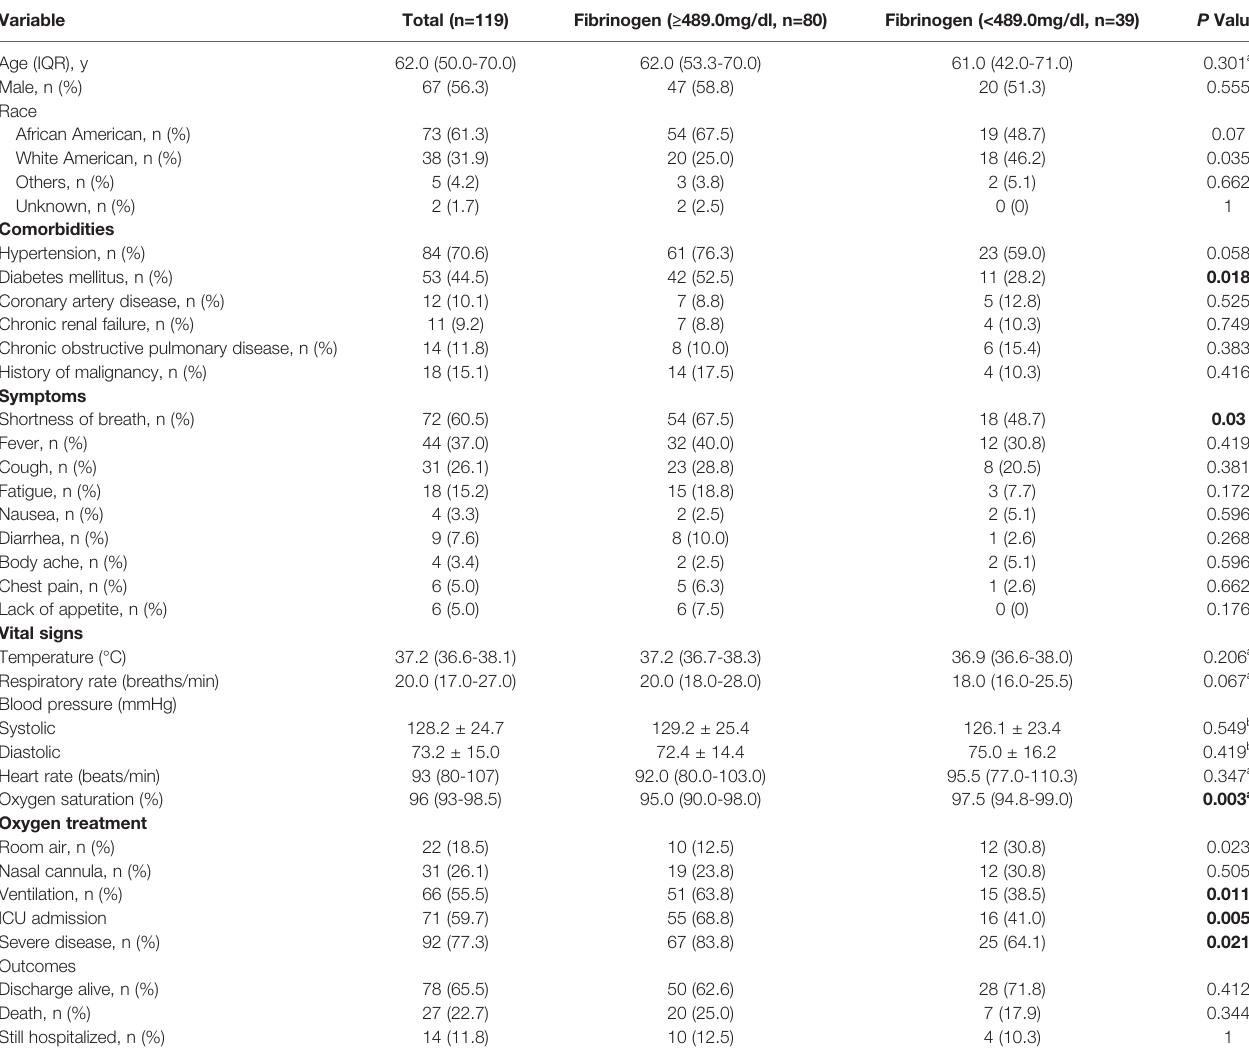
TABLE 1 | Comparison of baseline characteristics and outcome between COVID-19 patients with elevated and normal fi brinogen.